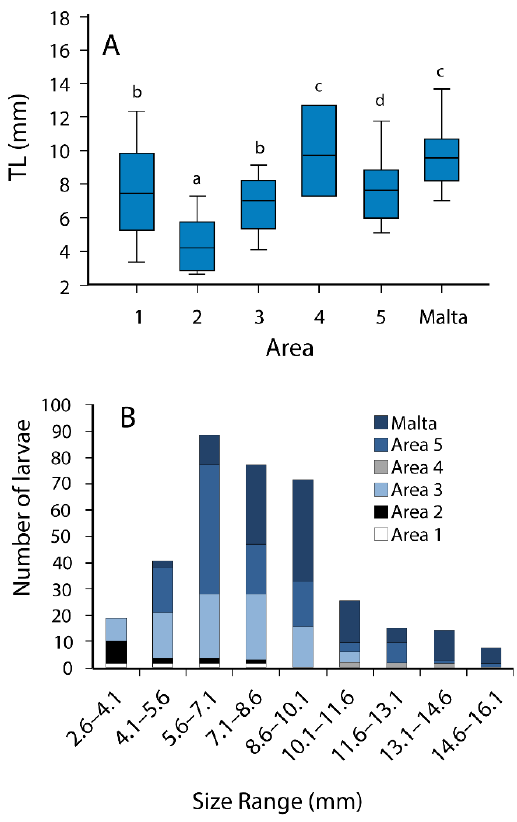
Figure 4. Mean total length (TL) and size distribution of sampled larvae. ( A ) Box plot of the TL among different areas. The bottom and top of the boxes are the first and third quartiles, while the whiskers indicate the 10 and 90 percentiles, and the band inside is the mean value. Lowercase letters (a–d) indicate statistically significant difference between the areas (pairwise tests, p -value < 0.05). ( B ) Histogram of size distribution of larval abundance (n) in the six considered areas.